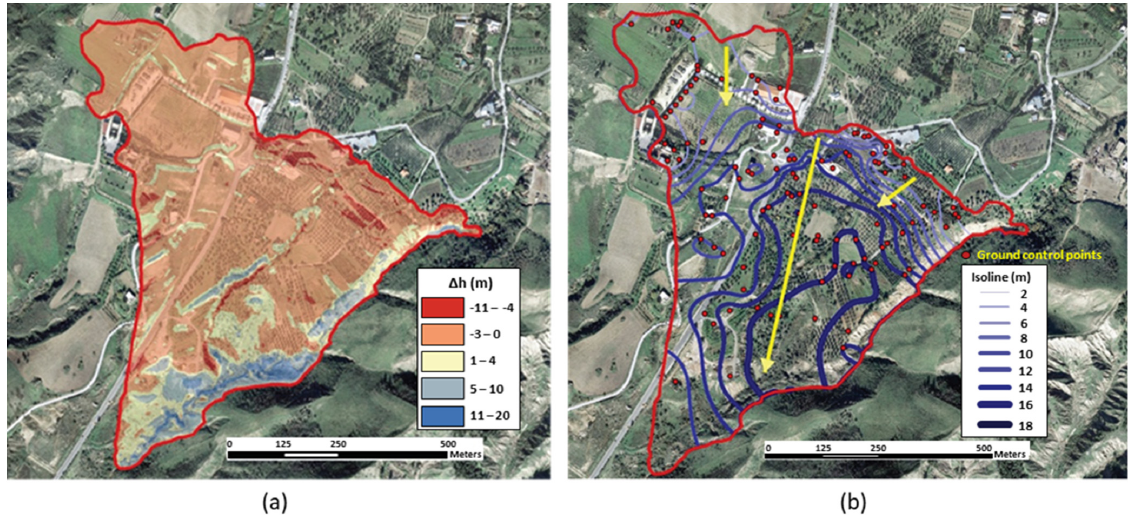
Figure 11. ( a ) Vertical and ( b ) horizontal displacement maps reconstructed by comparing pre − and post − event orthophoto and LIDAR surveys (modified from [23]).